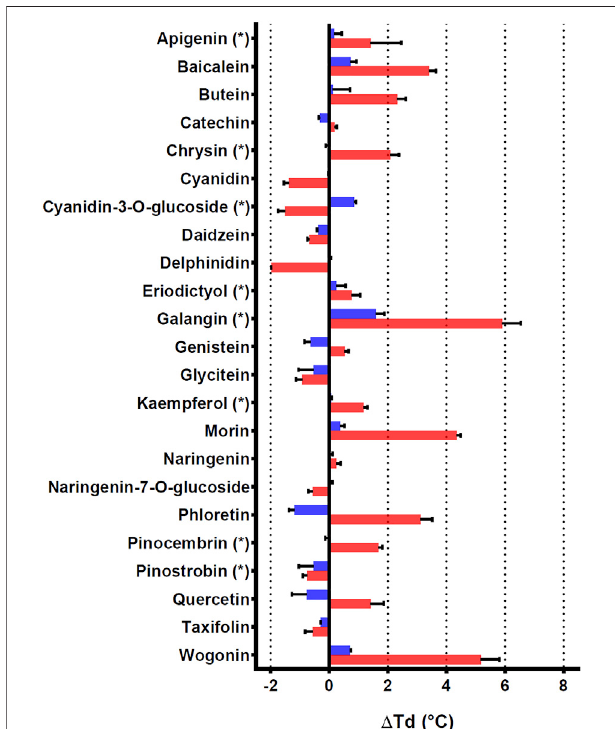
FIGURE 4 | Effects of 23 fl avonoids on the thermostability of PtGSTU19 and 20 isoforms. Thermostability of PtGSTU19 (blue bars) and 20 (red bars) isoforms has been analyzed by using 20 μ M of protein with or without 100 µM of chemical compounds diluted in 8% DMSO ( Supplementary Table S3 ). The denaturation temperature difference ( Δ Td) corresponds to the difference between the denaturation temperature of the proteininthepresence ofapotentialligand andareference assayinwhichthe potential ligand is replaced by an equivalent DMSO concentration.